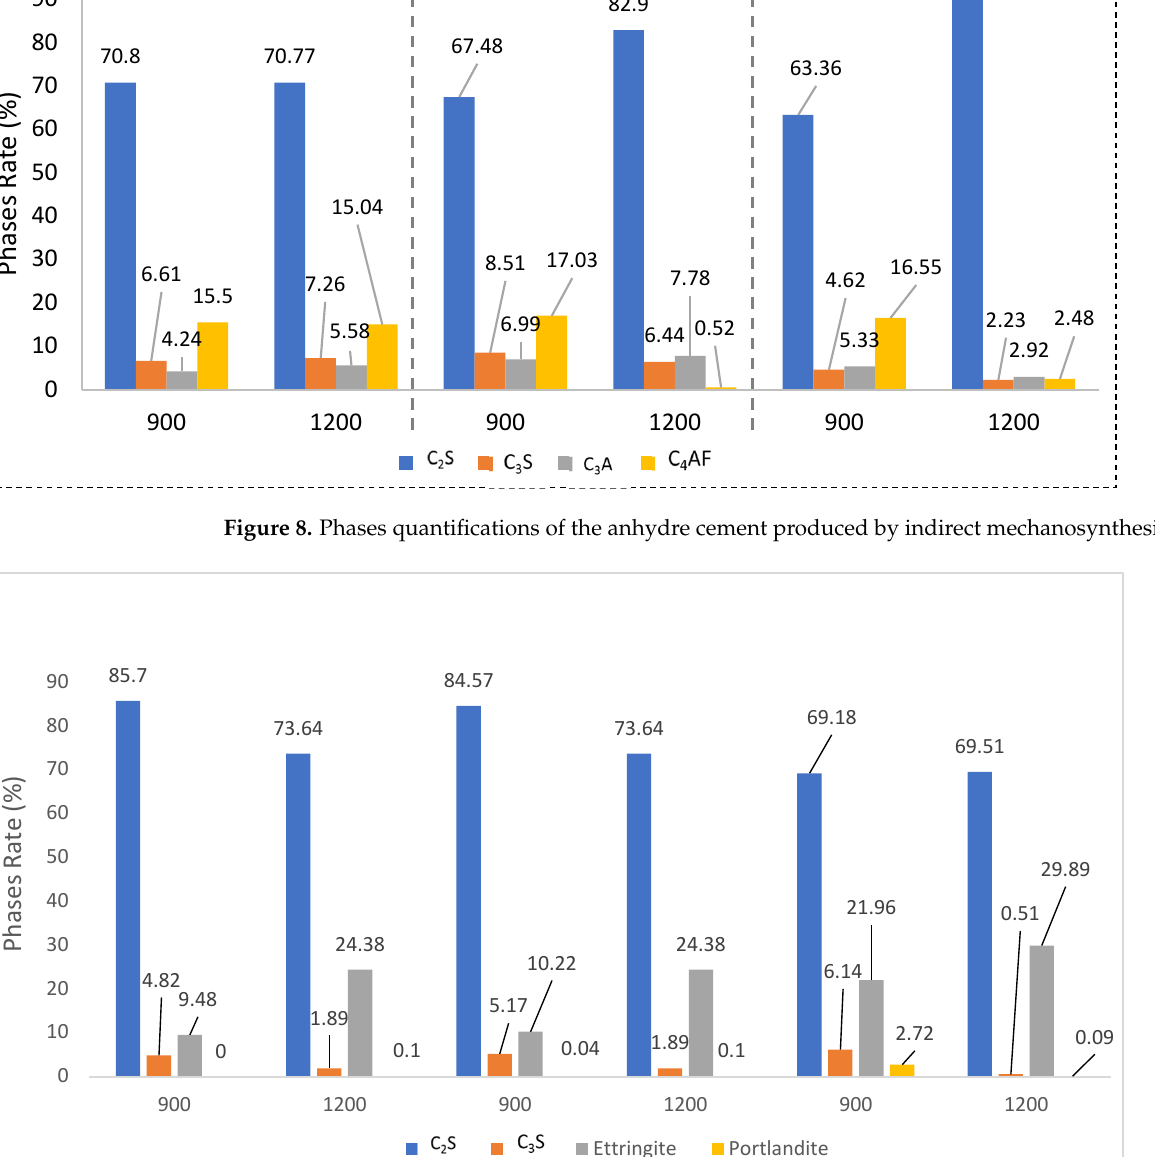
after 7 days of curing. 7 days of